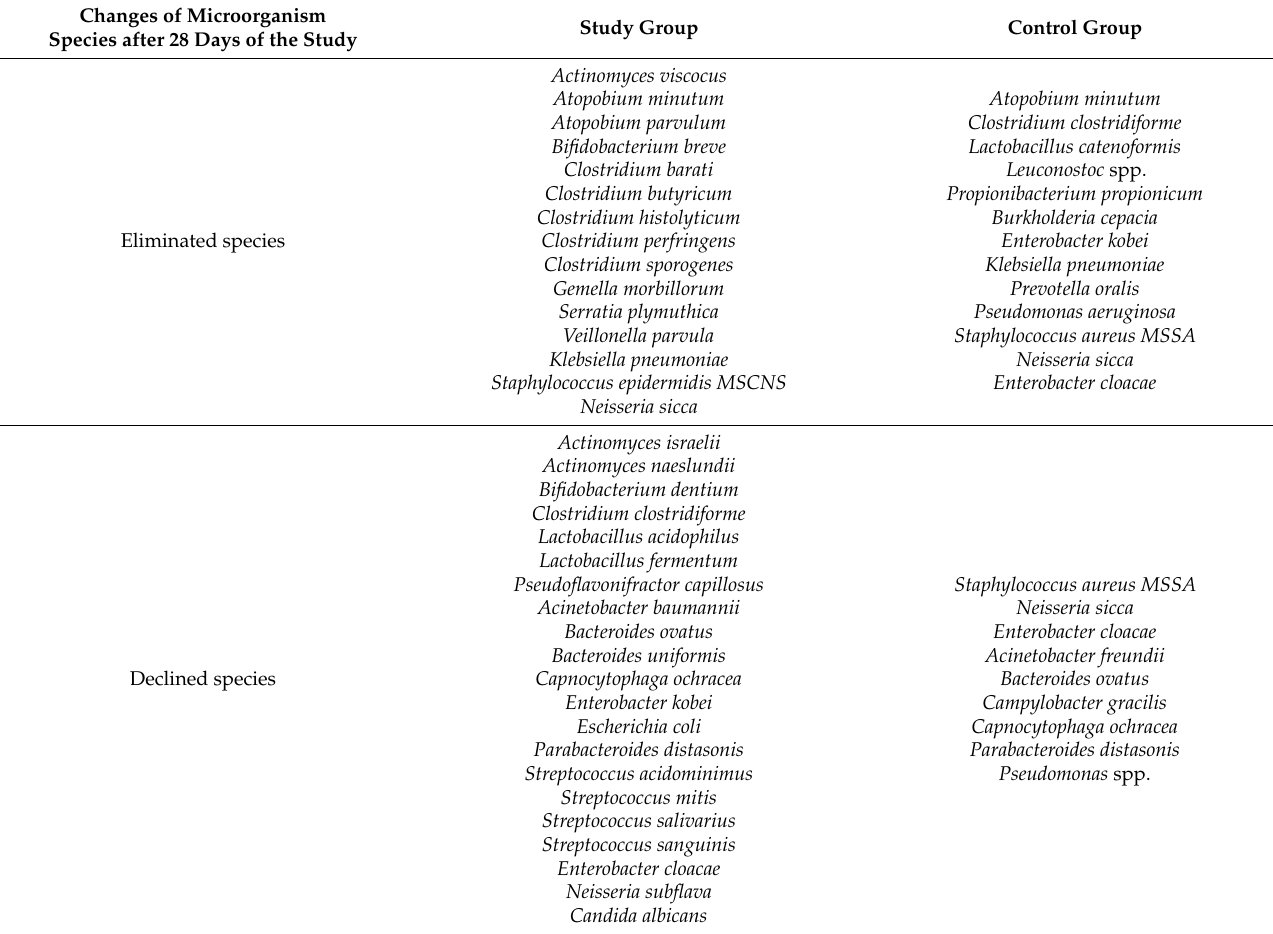
Table 6. Changes of oral microbiota in patients using the toothpaste with EEP and TTO (study group) or without EEP and TTO (control